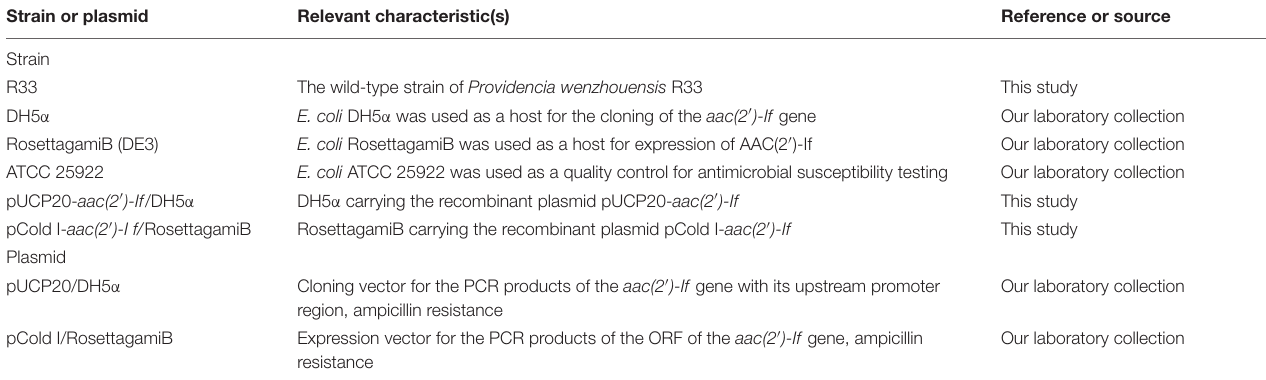
TABLE 1 | Bacteria and plasmids used in this work. Strain or